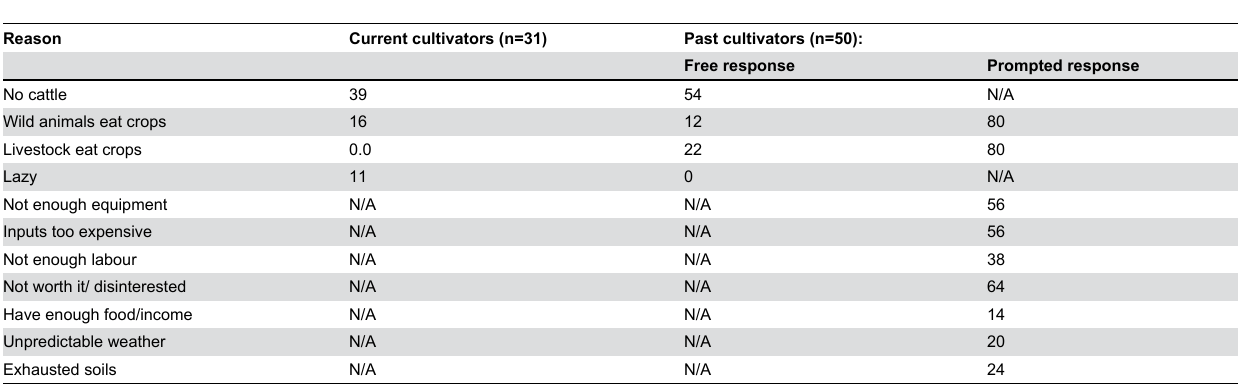
Table 4. Reasons why people have stopped cultivating (% of responses).